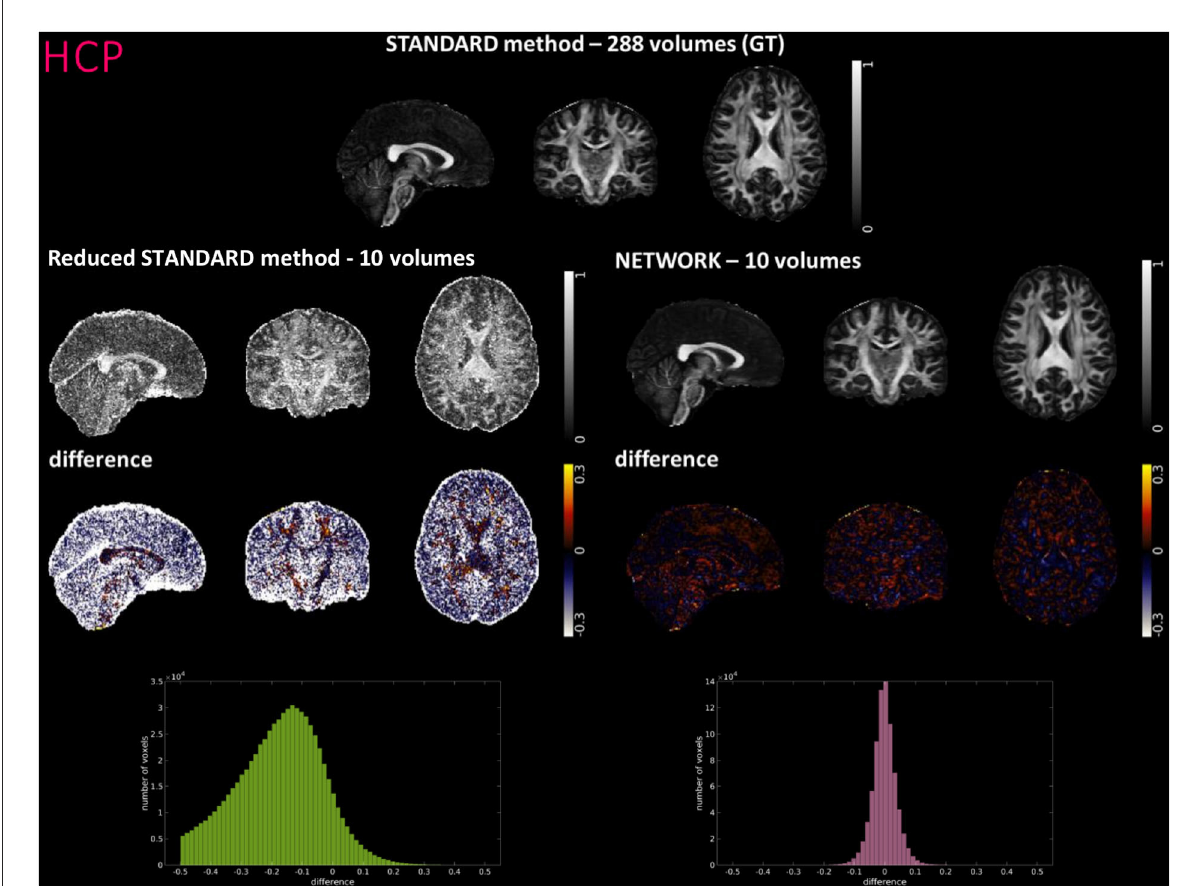
FIGURE4 For a random subject from the Human Connectome Project (HCP), each fractional anisotropy (FA) map is shown: the standard FA map calculated with model fitting from all diffusion weighted (DW) volumes [STANDARD method − 288 volumes (GT)], the standard FA map calculated with model fitting from a DW subset of 10 volumes (Reduced STANDARD method-10 volumes), and the network FA map from a DW subset (NETWORK-10 volumes). The “difference” shows the voxel-wise difference between GT FA and either the (Reduced STANDARD methods − 10 volumes) FA or the (NETWORK − 10 volumes) FA maps. At the bottom, there is the histogram of the differences. All color bars have arbitrary units (a.